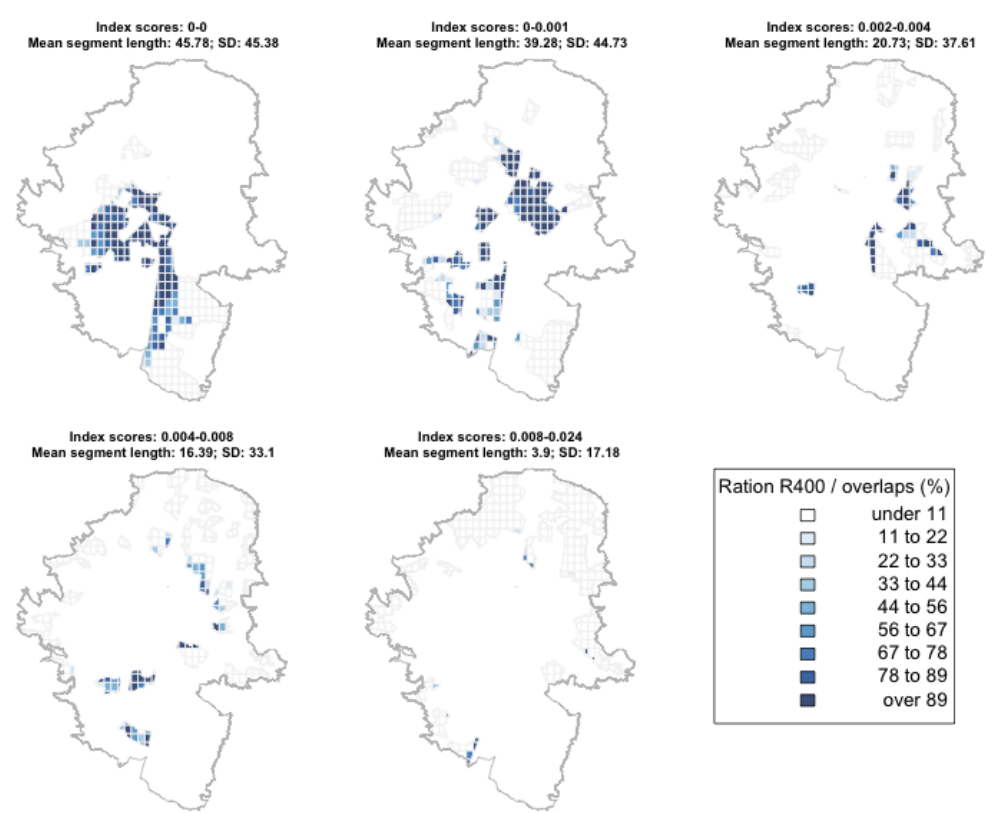
Figure 15. A choropleth array of Medellín based on SISBEN score quintiles, following the same sampling format shown in Figure 12. However, the plots run low vulnerability top left to high vulnerability score bottom right. tions with the choropleth format described above (see Figure 13). The morphological analysis of